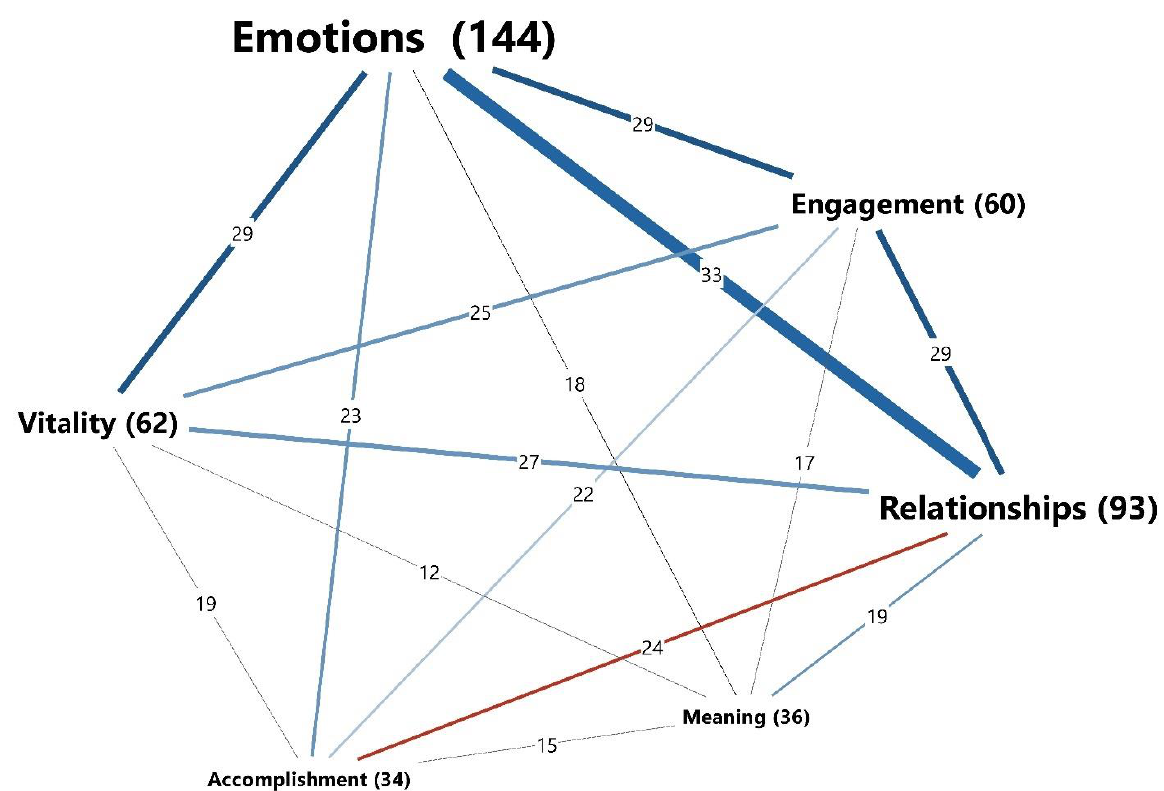
Figure 3. The six main categories and the strengths of their connectivity based on the frequency of the coded segments in the debrief transcripts (presented in parentheses). The feature Code Proximity model of MaxMaps in MAXQDA was used to generate the visualisation.